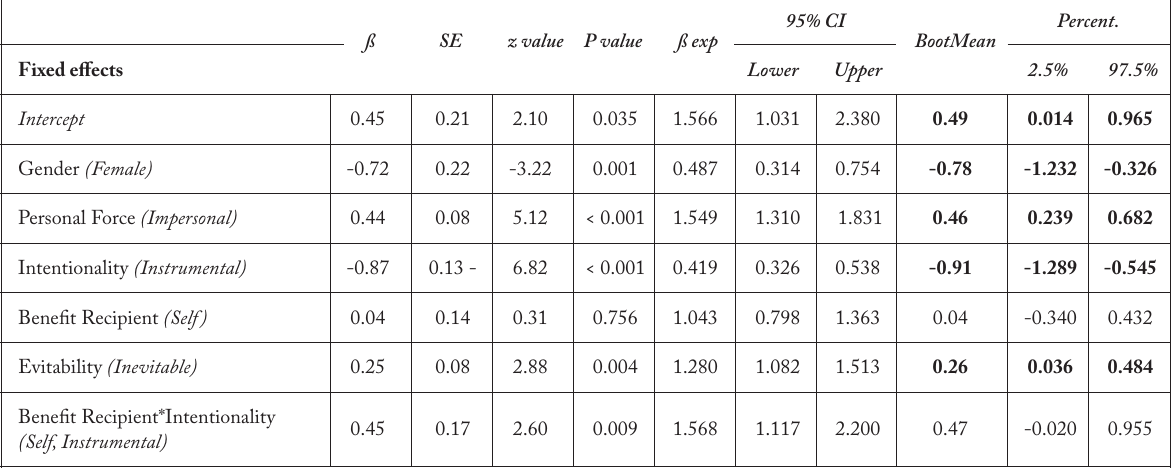
Table 6. Summary of linear mixed effects model on moral choices for Study 2. Higher ß values indicate higher rates of utilitarian